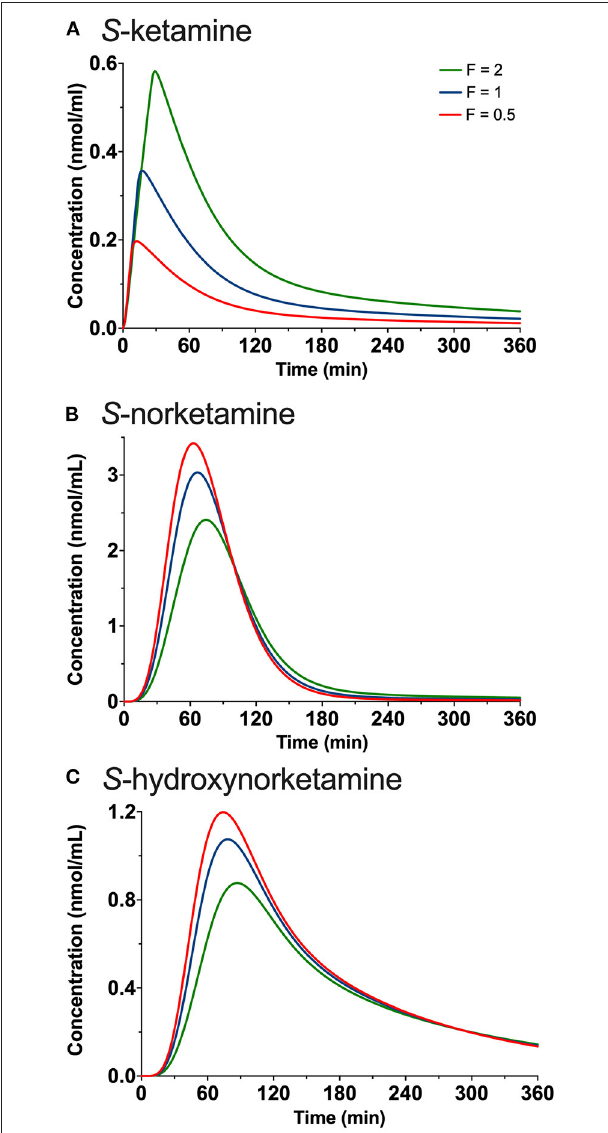
FIGURE 4 | Simulations showing the effect of changing the duration of placement of the 50mg oral thin file in the mouth by changing both F1 (bioavailability) and D (duration of absorption) on the plasma concentrations of S- ketamine (A) , S- norketamine (B) and S- hydroxynorketamine (C) . F is a factor by which D1 is adjusted and ranges from 0.5 (red lines) to 1 (blue lines) and 2 (green lines).